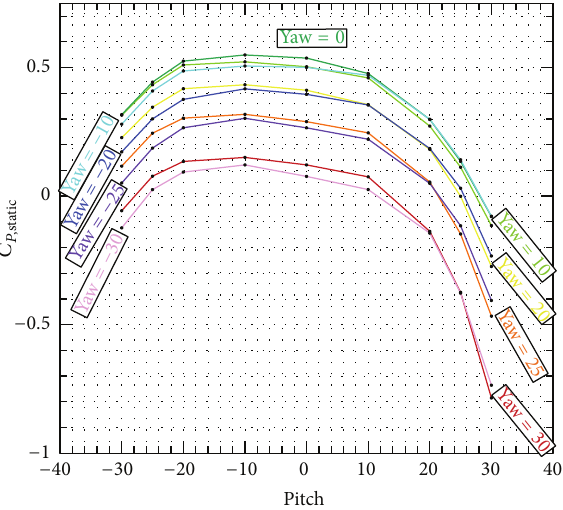
Figure 10: Pitch and coefficient of static pressure with lines of constant yaw, 81 (9 × 9)